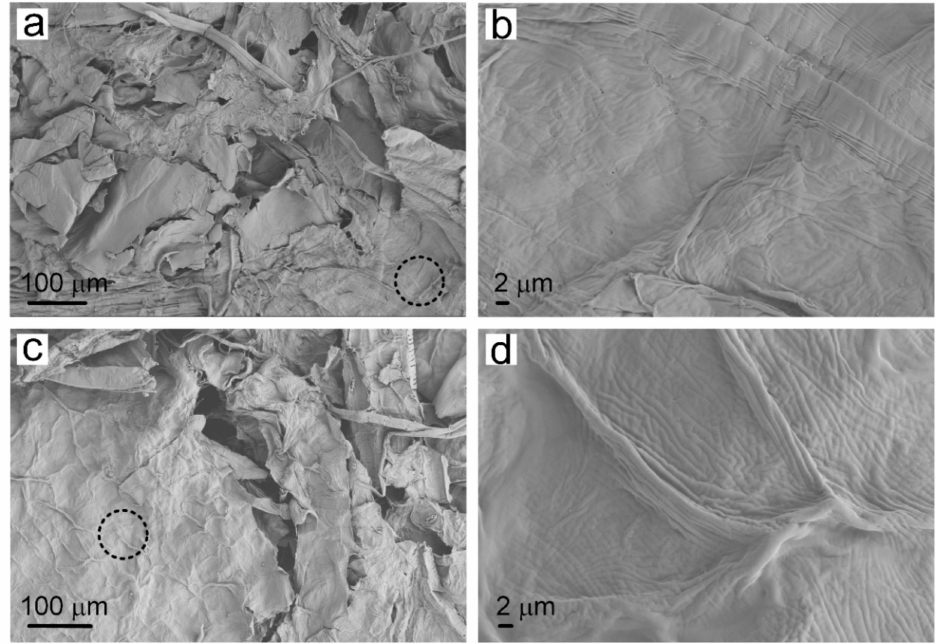
Figure 2. SEM images of ( a ) reconstituted tobacco paper-base and ( b ) the magnified image of the paper-base sheet; SEM images of ( c ) PT-tobacco paper-base and ( d ) the enlarged area of the PT-paper- base